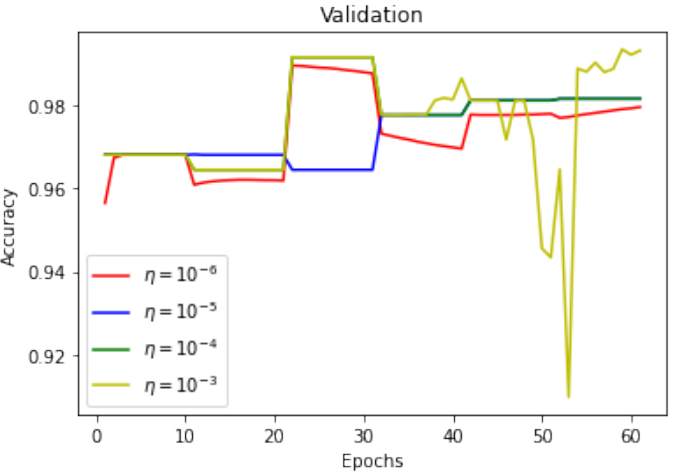
Figure 17. Validation Accuracy with Different Learning Rates.